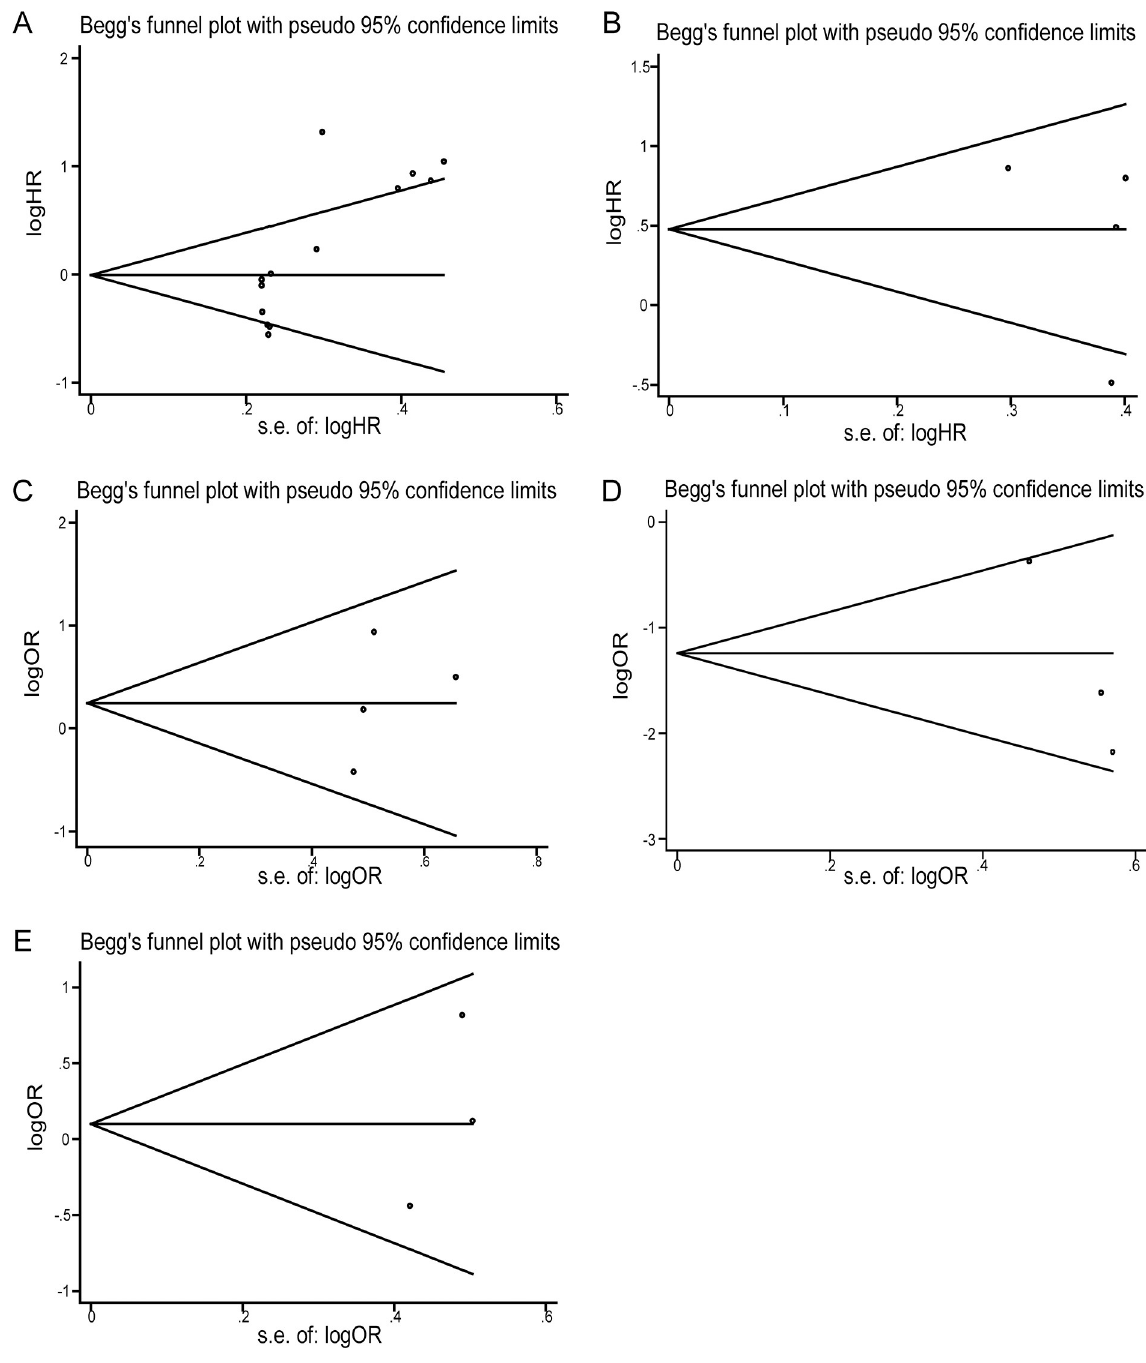
Fig 4. Funnel plot of the publication bias. (A) Funnel plot of the publication bias for overall survival. (B) Funnel plot of the publication bias for recurrence-free survival. (C) Funnel plot of the publication bias for gender. (D) Funnel plot of the publication bias for histological classification; (E) Funnel plot of the publication bias for